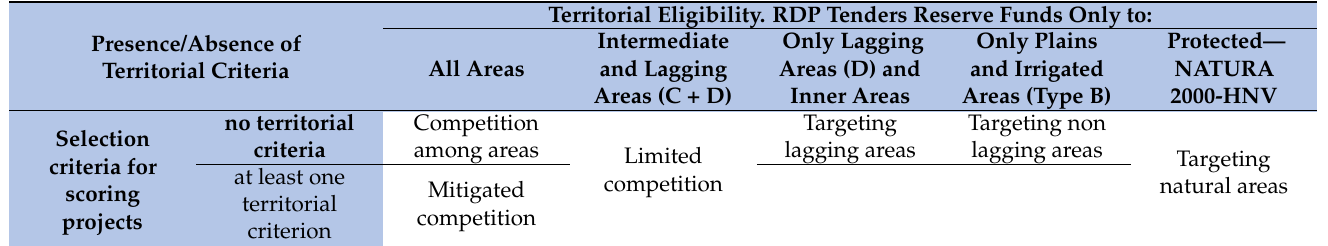
Table 2. Modes of project selection, based on combination of territorial eligibility and selection criteria. Territorial Eligibility. RDP Tenders Reserve Funds Only